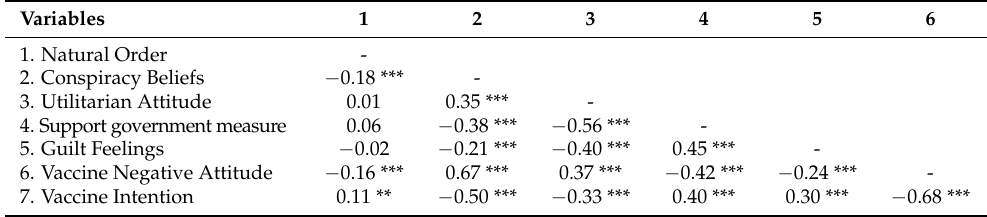
Table 2. Correlations.